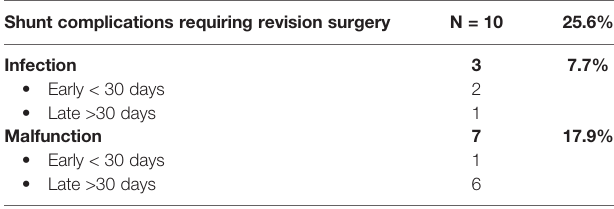
TABLE 2 | Shunt complications requiring revision